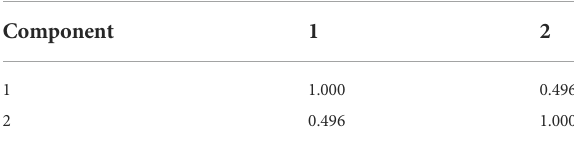
TABLE 9 Component correlation matrix for identifying the role of MCF.